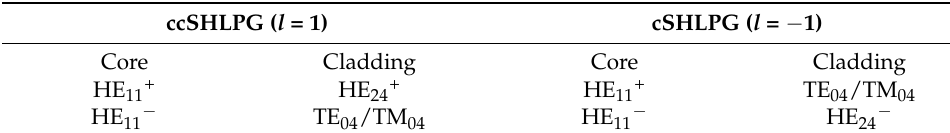
Table 1. Mode coupling occurring in a SHLPG.